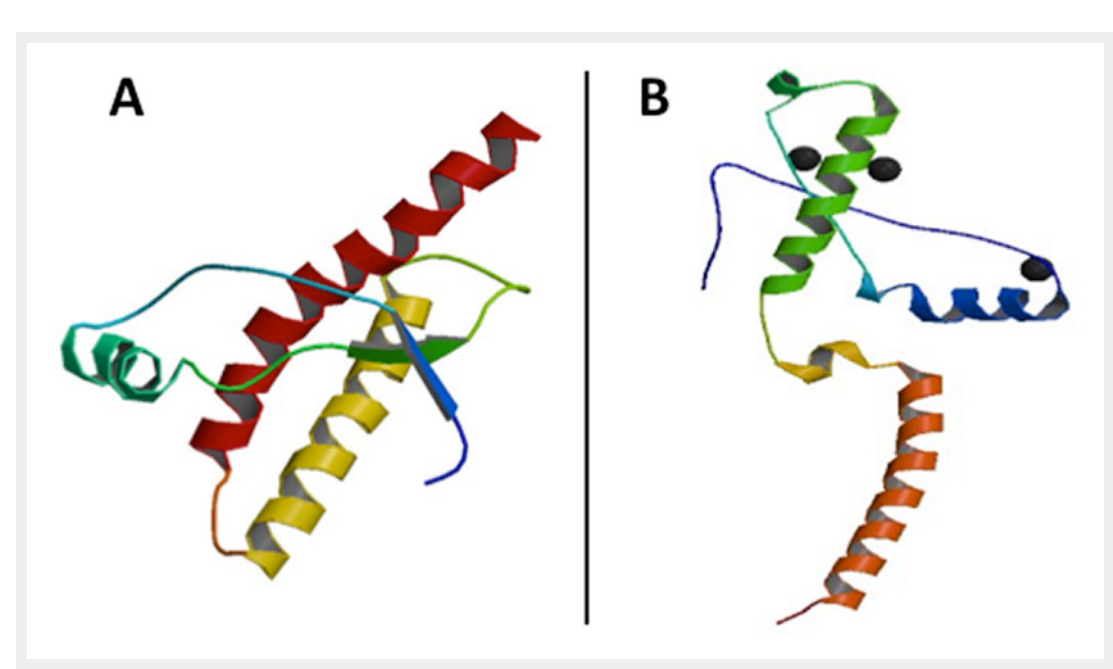
Figure 1 Three dimensional structure of PrP C solved by ( A ) nuclear magnetic resonance (PDB code 1QM1) and ( B ) X-ray diffraction (PDB code